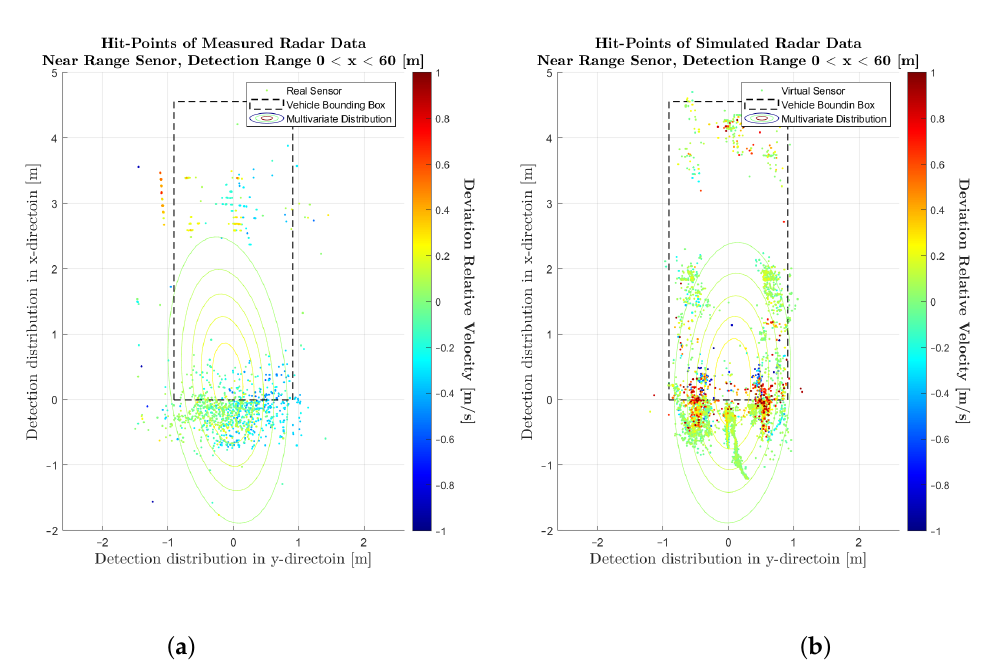
Figure 7. Evaluation of the detections in the range of 0 to 60 m of the near-range radar sensor and sensor model. ( a ) Scatterplot of detections for the real sensor. ( b ) Scatterplot of detections for the sensor model.